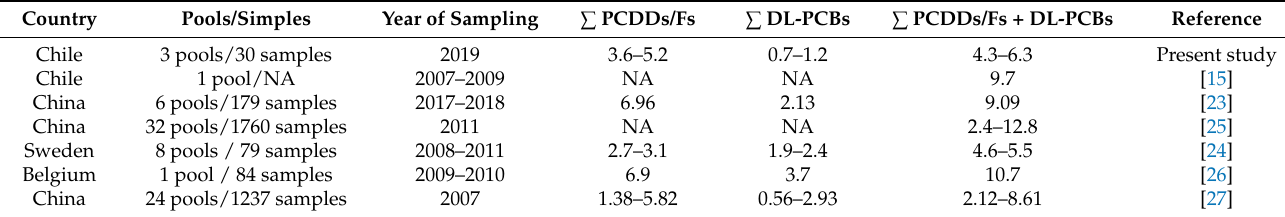
Table 3. Levels of dioxin-like polychlorinated biphenyls (DL-PCBs), polychlorinated dibenzodioxins (PCDD), and polychlo- rinated dibenzofurans (PCDF) in human milk in similar